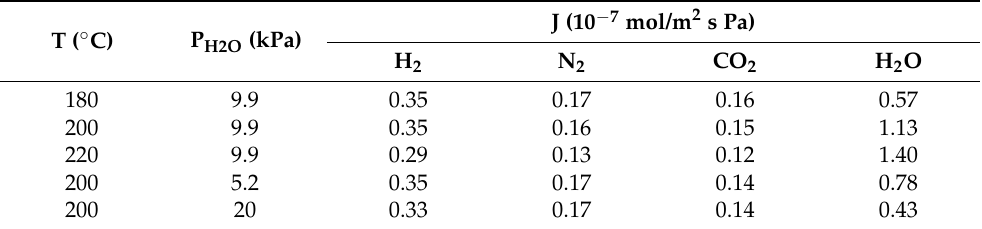
Table 2. Permeance (J) of each gas obtained with the double-layer silicone membrane with different temperatures and water partial pressures in the